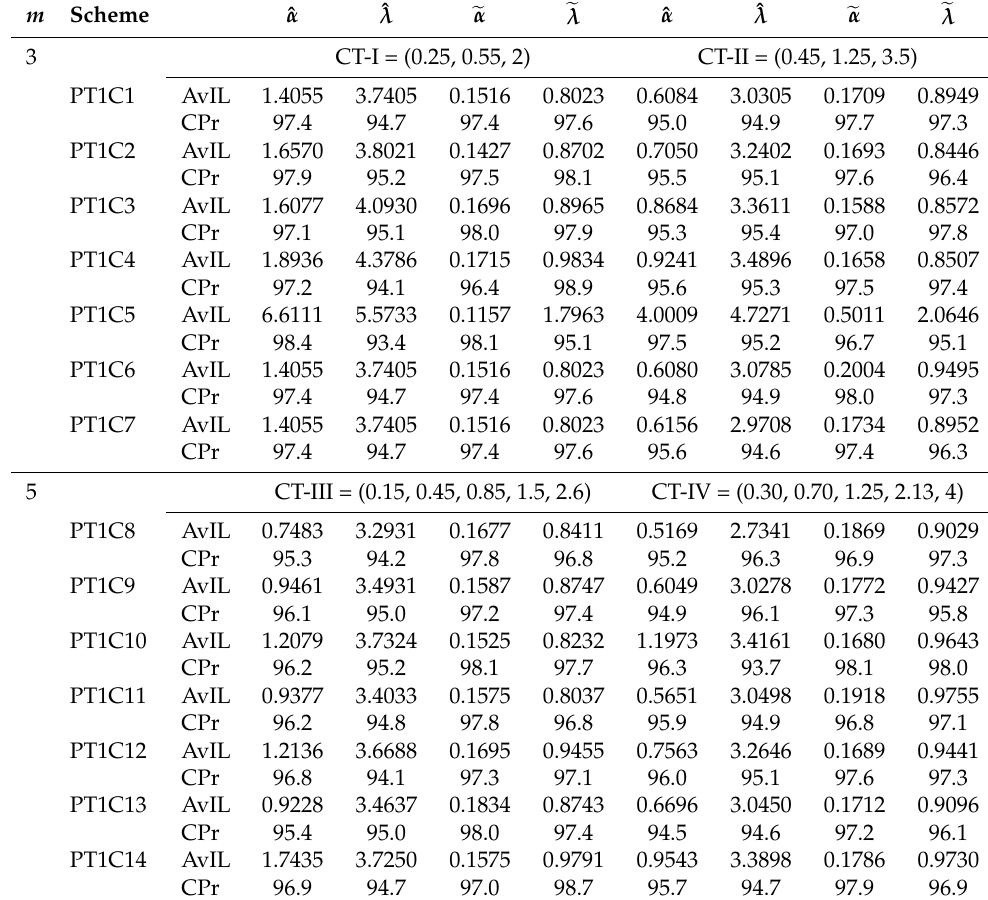
Table 7. AvILs and CPr(in %) values and MSErs of the ML and BEs for NH model with α = 0.5 and λ = 1.5 under various censoring schemes at n =